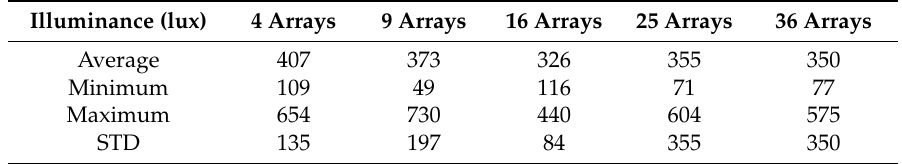
Table 7. Illuminance at ∅ 1/2 = 30 ◦ .